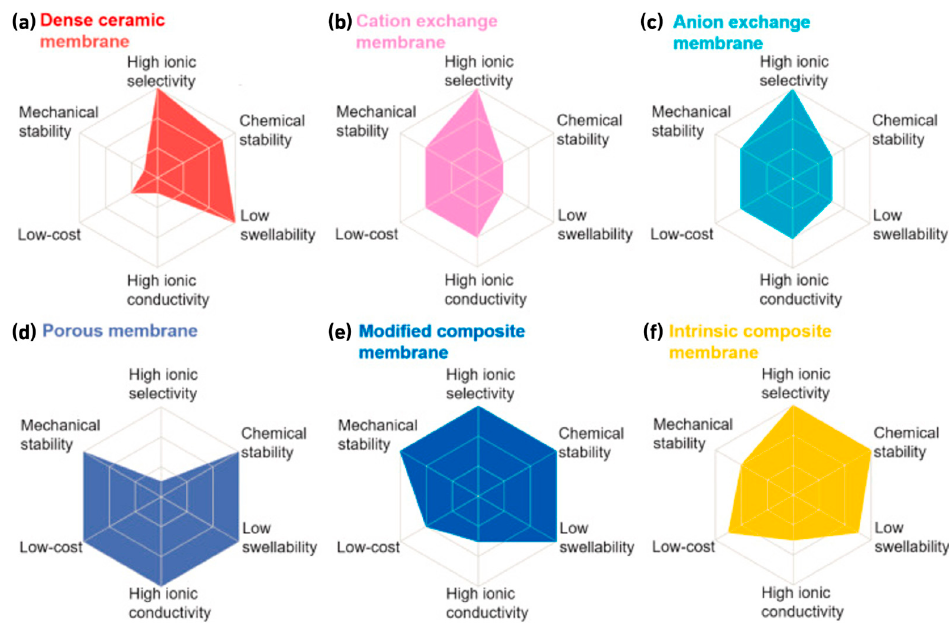
Figure 1. Radar charts of the performance parameters of different membranes [34] .